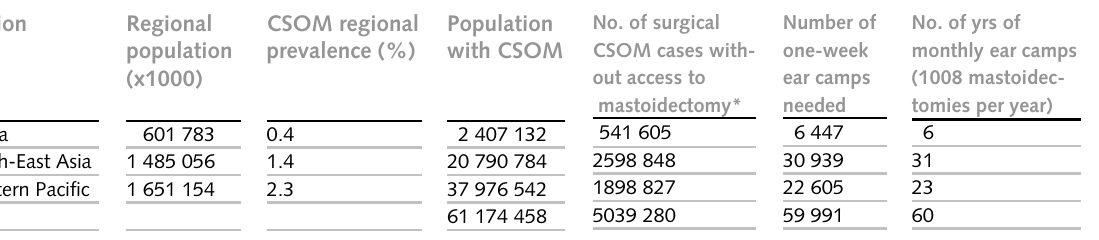
Table 15. Number of ear camps in three regions and the estimated time for reducing the mastoidectomy backlog, i.e. the number of CSOM cases without access to mastoidectomy